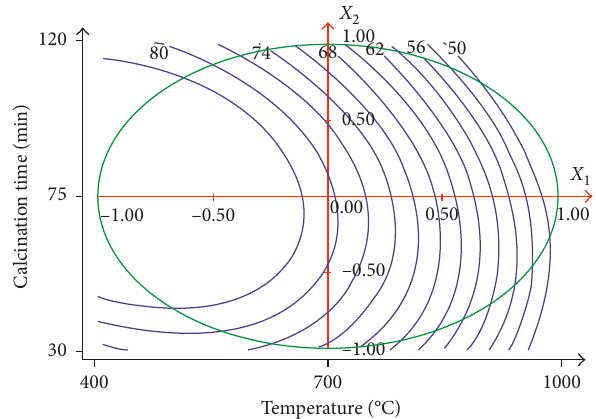
Figure 2: Variation of the methylene blue adsorption capacity ( Y mg · g − 1 ) as a function of calcination temperature and